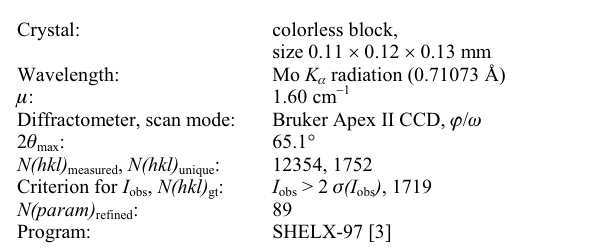
Table 1. Data collection and handling.